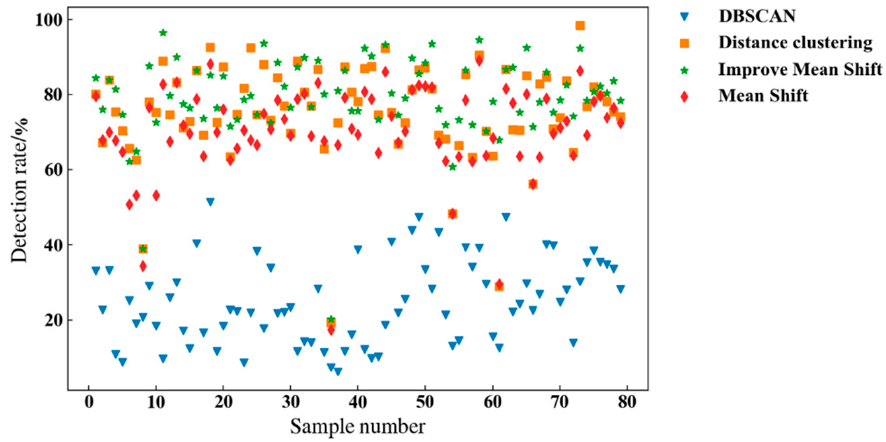
Figure 7. Detection ratio of oil tea fruit based on the RGB color space.